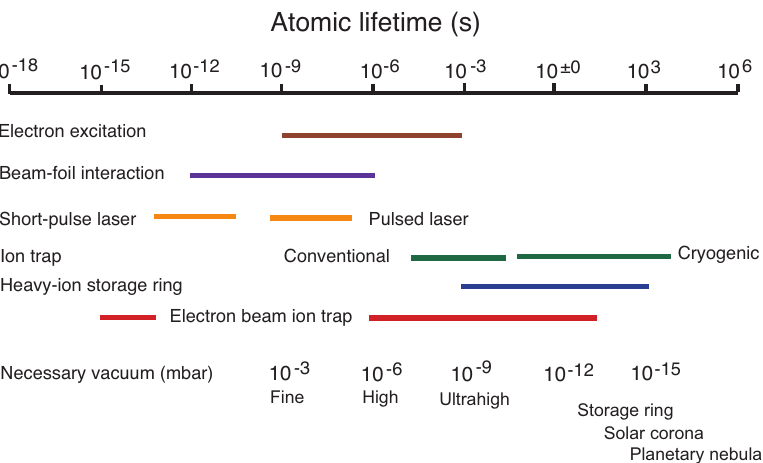
Figure 1. Overview over the atomic lifetime ranges discussed in the text, with rough working ranges of principal lifetime measurement techniques and typical ambient pressures. Individual experiments also target phenomena outside the coloured bars, for example, pump–probe experiments on the attosecond scale. These, however, do not (yet) measure atomic level